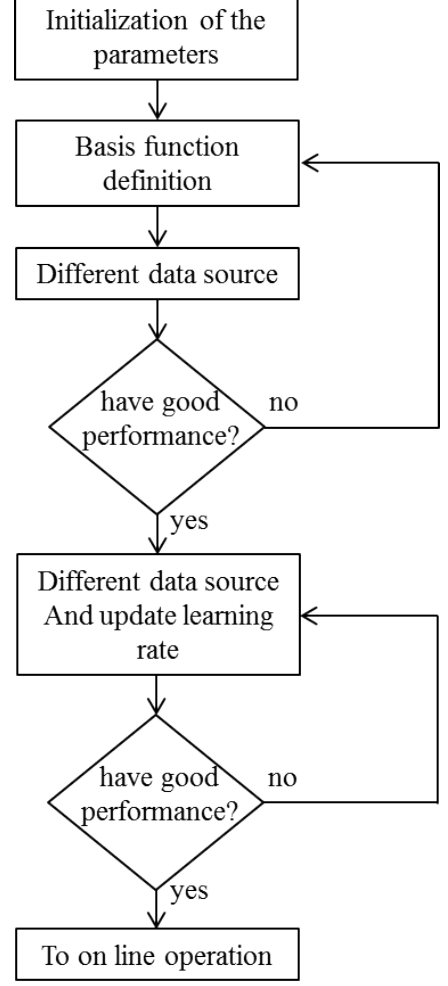
Figure 3. Flow chart of the neural network controller in off-line